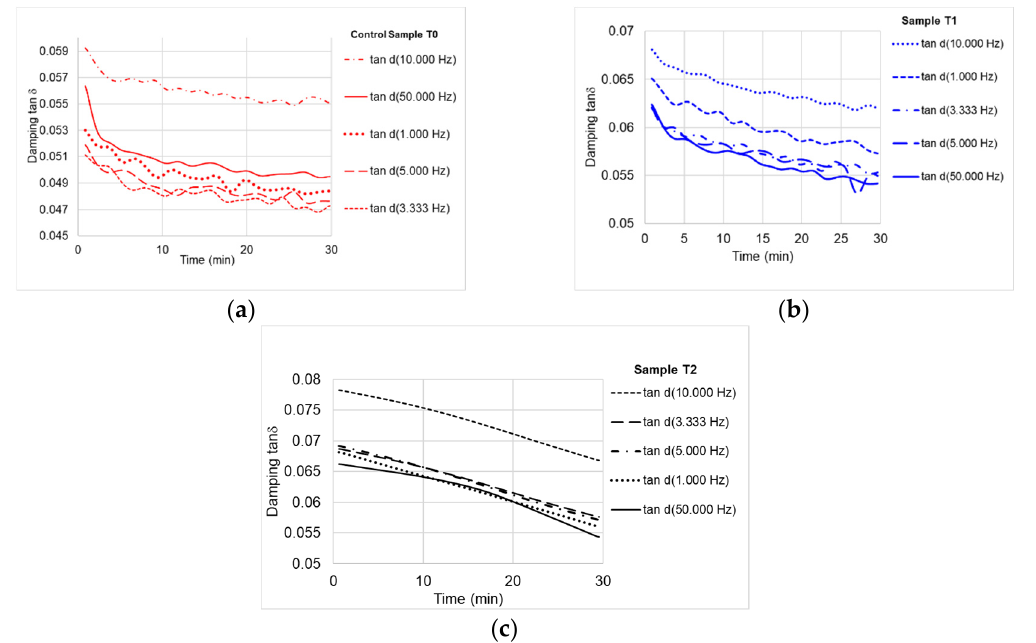
Figure 12. Variation of damping tan δ with loading frequencies: ( a ) control sample; ( b ) sample T1 (first treatment); ( c ) sample T2 (second treatment).